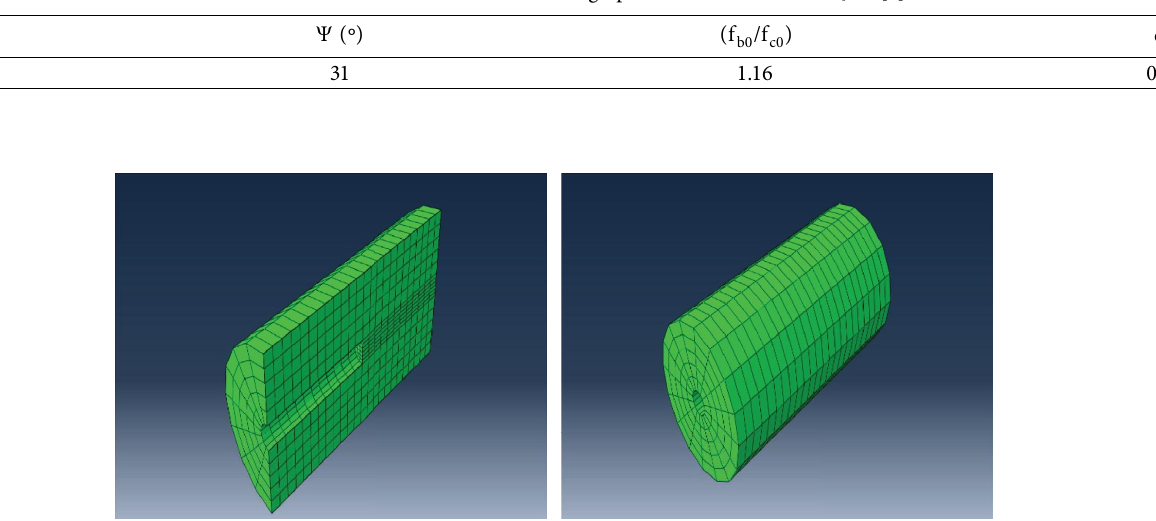
Table 5: Parameters of the concrete damage-plastic method in ABAQUS [1].